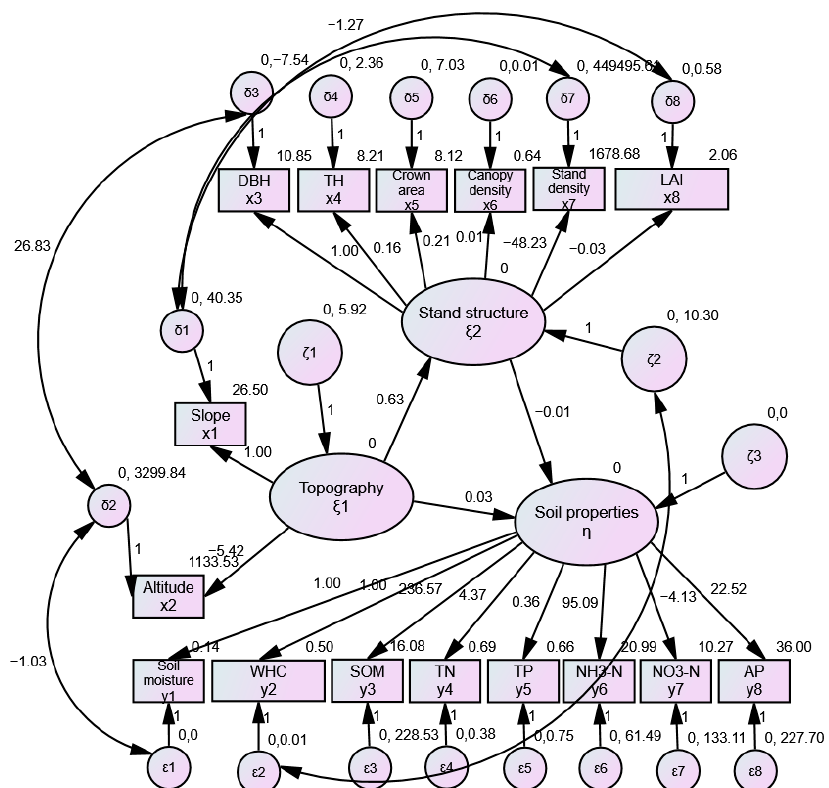
Figure 2. The modified model. Note: The numbers correspond to the standardized path coefficients on the single arrows, and to correlation coefficients on the double arrows. A value outside of a rectangular box is the mean of the indicator, and a value outside of a round box is the residual error after modification. In the figure, DBH is the abbreviation for diameter at breast height; TH is the acronym for height of tree; LAI is the acronym for leaf area index; WHC is the abbreviation for soil maximum water holding capacity; SOM is the acronym for soil organic matter; TN is the is the acronym for total nitrogen; TP is the acronym for total phosphorus; NH 3 -N is the acronym for ammonia-nitrogen, NO 3 -N is the acronym for nitrate-nitrogen; and AP is the acronym for available phosphorus.